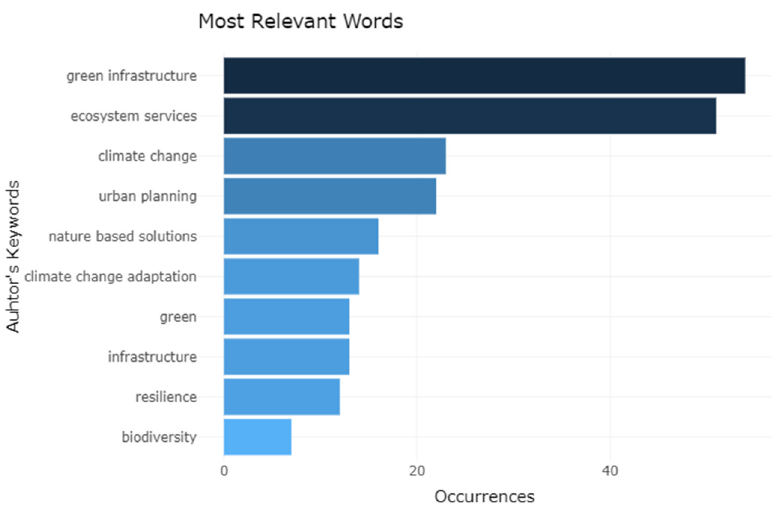
Figure 5. Comparison of Author Keywords by number of occurrences. Source: Biblioshiny. Own compilation.